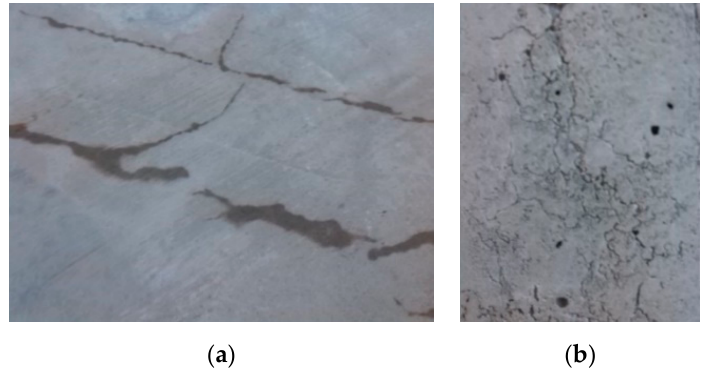
Figure 1. Cracks in concrete basement structures. ( a ) Water penetration through cracks in the ground floor. ( b ) Cracks in the wall in the building substructure.